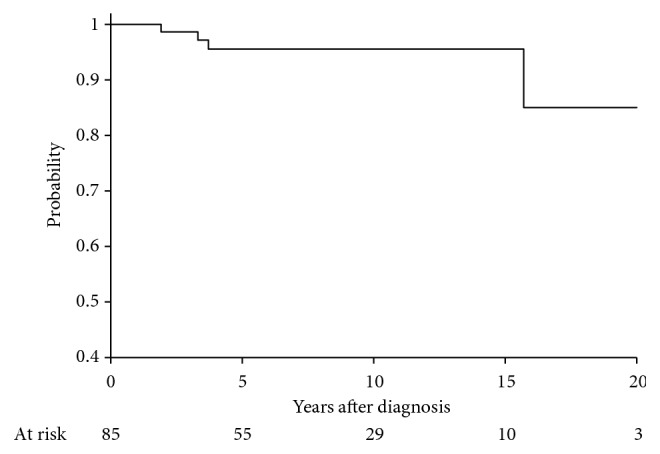
Local control at 5 years, 95.6% (86.9–98.6).